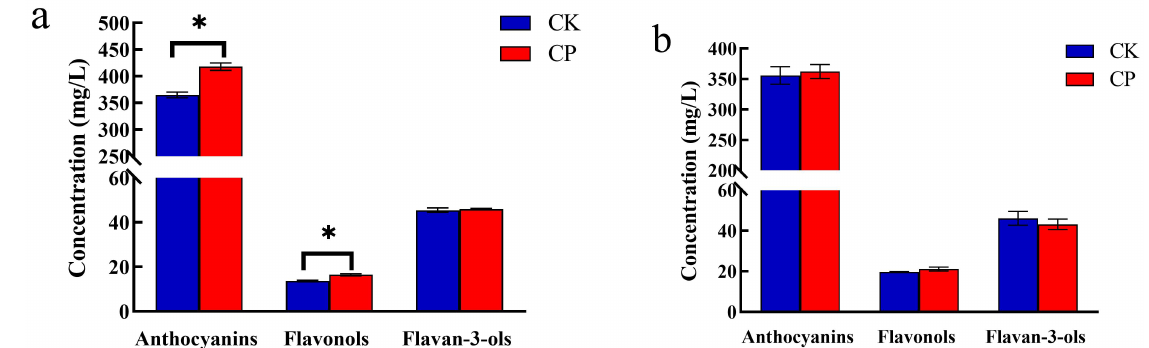
Figure 8. Effect of covering purslane on the concentrations of different flavonoid compounds in wines. ( a ) in the year 2018; ( b ) in the year 2019. * indicates significant differences between the control and covering purslane ( p < 0.05, t -test) .